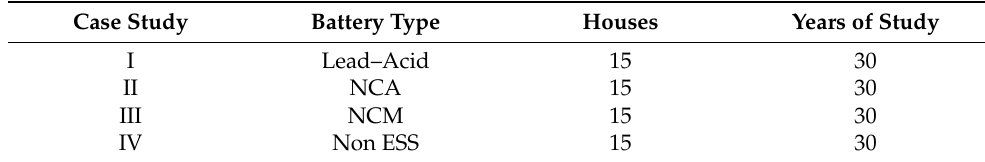
Figure 1. Total daily energy demand for every month for the micro-grid (kWh). Table 3. Representative case studies.